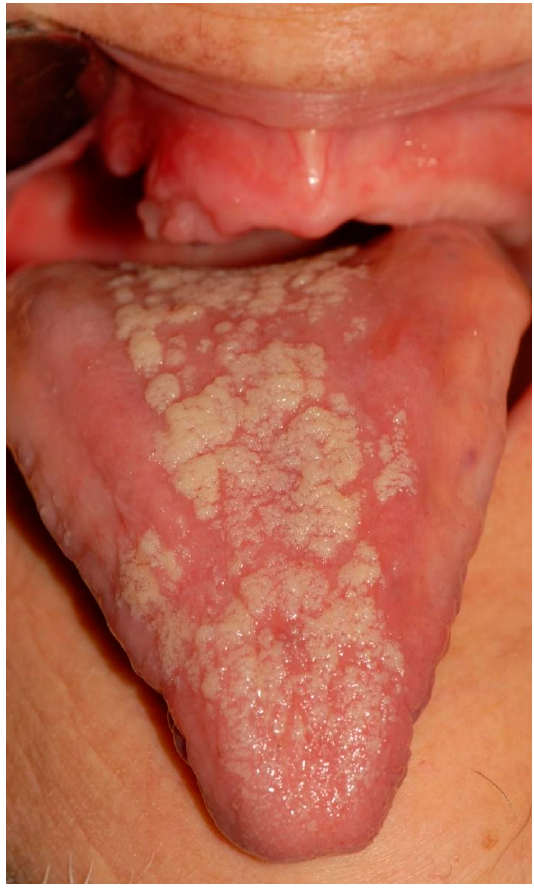
Figure 1. Patchy, erythematous depapillation of the dorsal tongue with regions of elongated filliform papillae. Histological examination showed a picture of atrophy as well as a hyperkeratosis without dysplasia (Patient no. 12, Table 2).